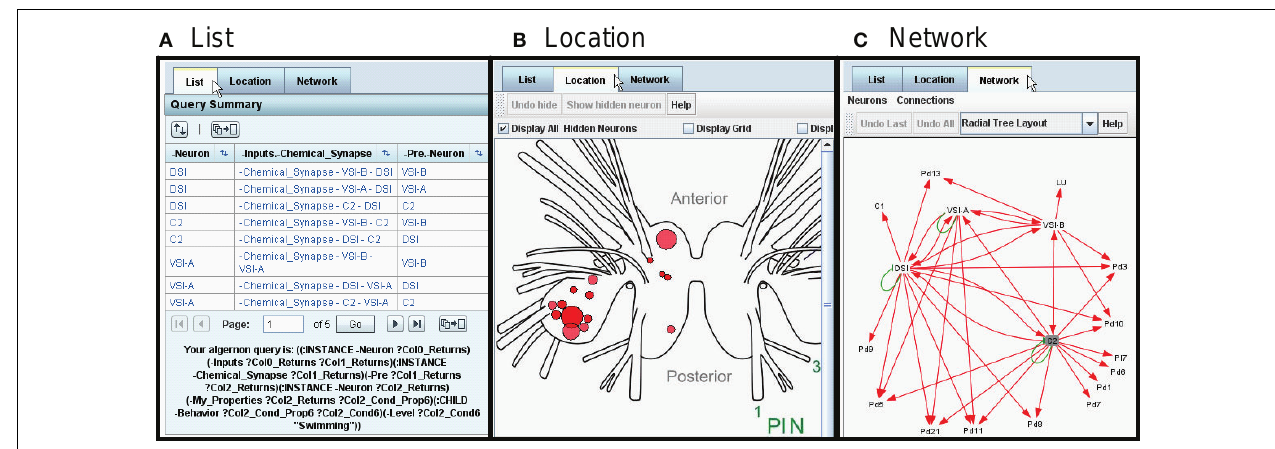
FIGURE 7 | Three ways to view the results: List, Location, and Network (tabs). (A) The List view shows all parts of the search result as clickable items. (B) The Location view displays the neuron cell bodies on a map of the nervous system. (C) The Network view displays the results in the form of a synaptic wiring diagram. Red arrows represent chemical synapses and green arrows represent electrical